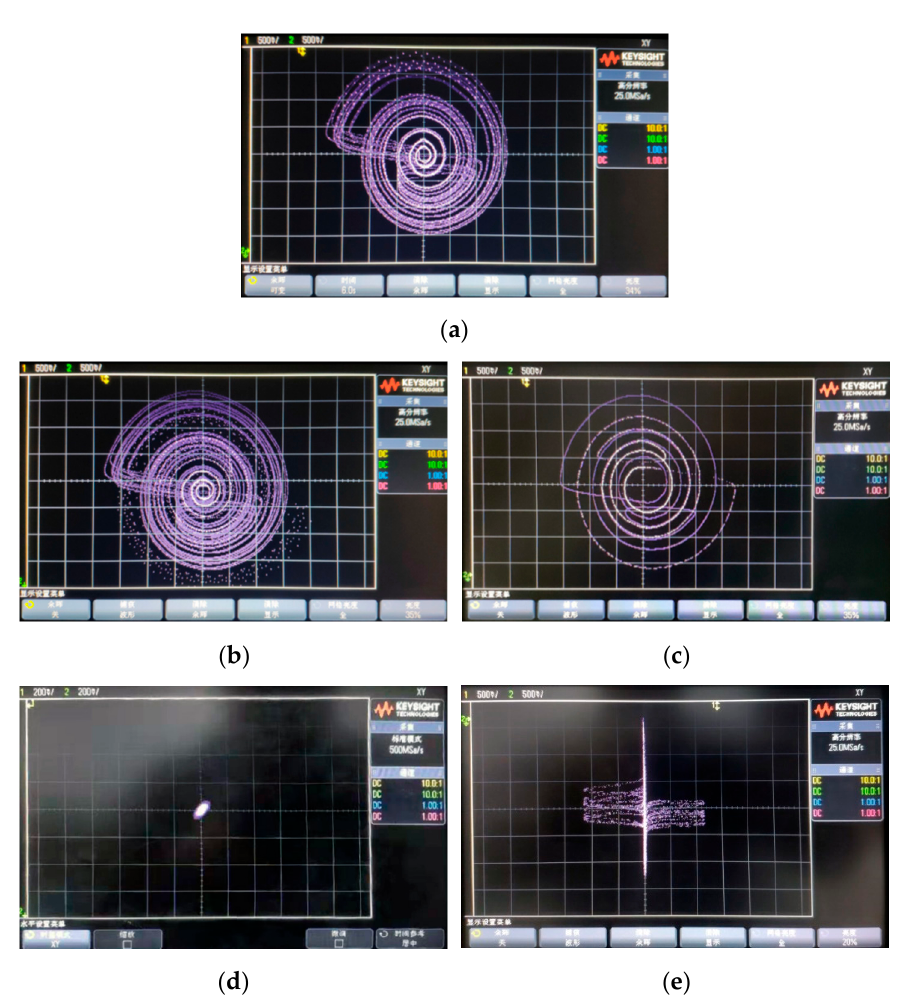
Figure 19. Digital signal processing (DSP) implemental results of the chaotic system: ( a ) the typical chaotic attractor; ( b ) the coexisting chaotic attractor; ( c ) the coexisting period-1 attractor; ( d ) the point attractor; ( e ) the typical chaotic attractor.